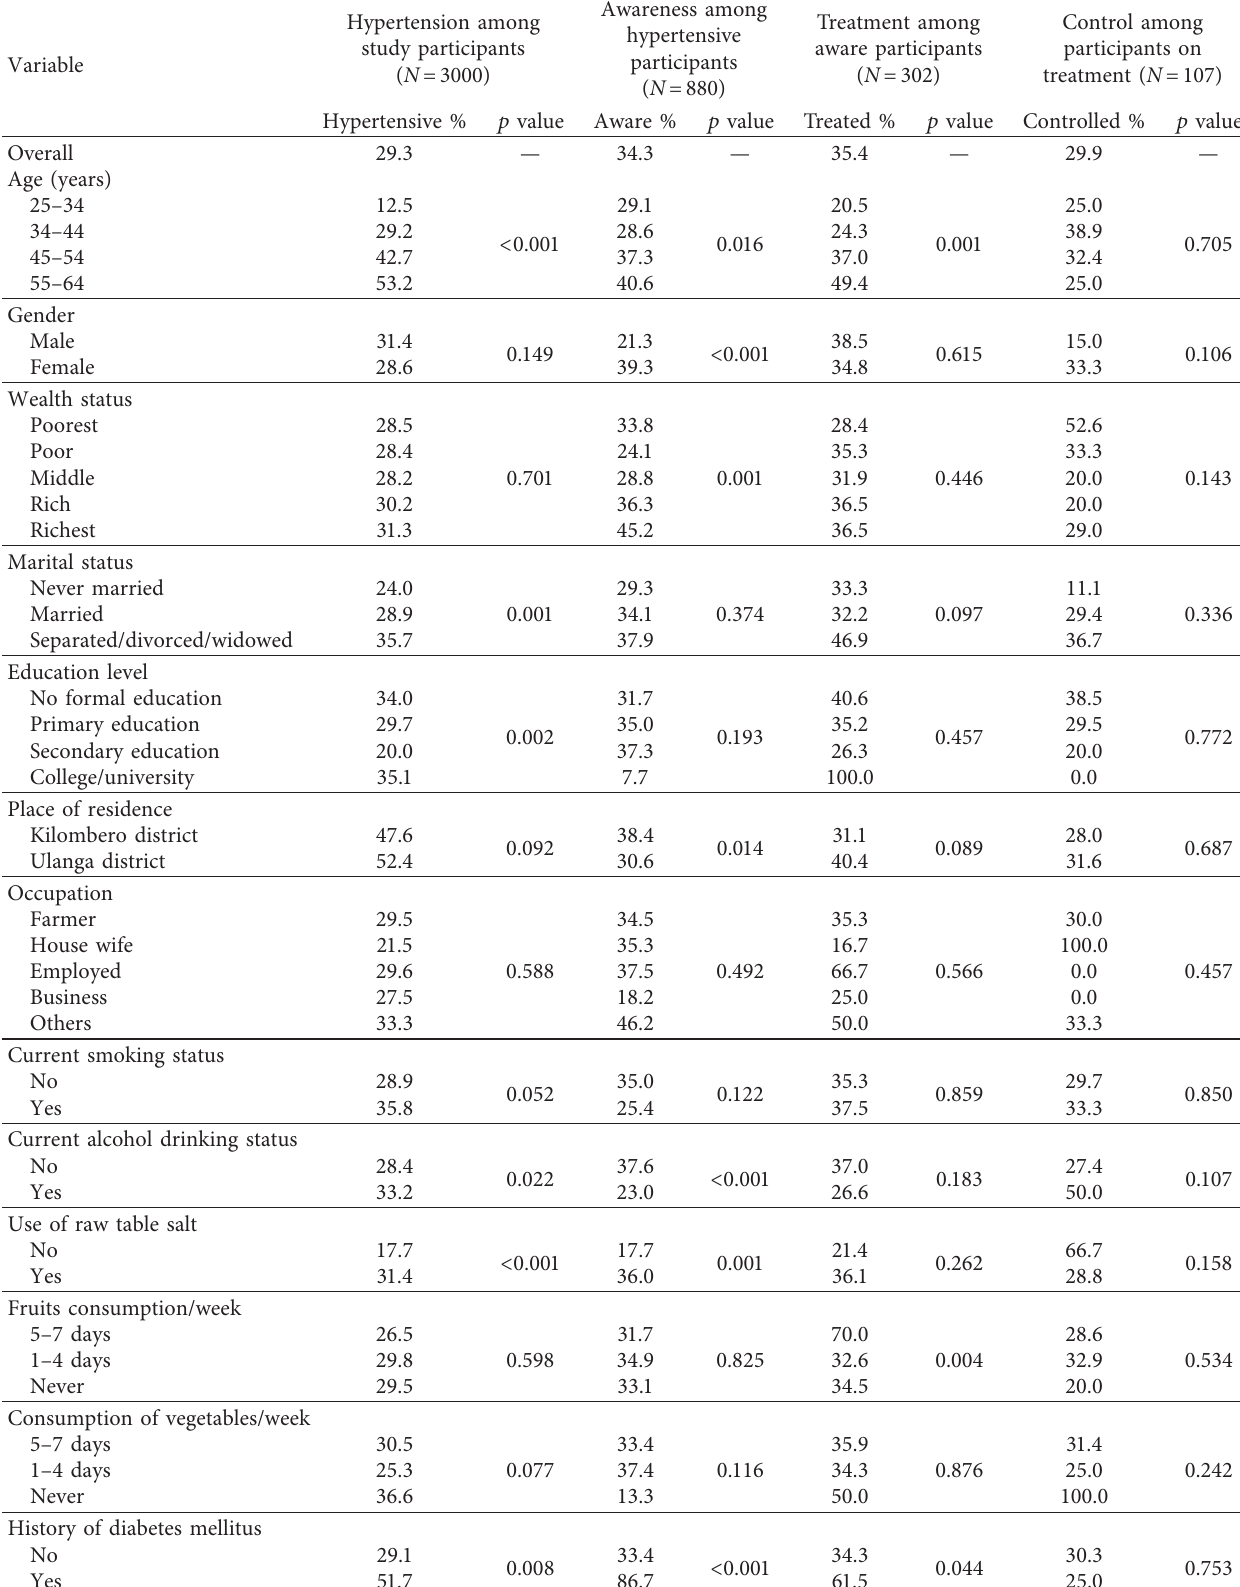
Table 2: Prevalence, awareness, treatment, and control of hypertension among study participants by selected population